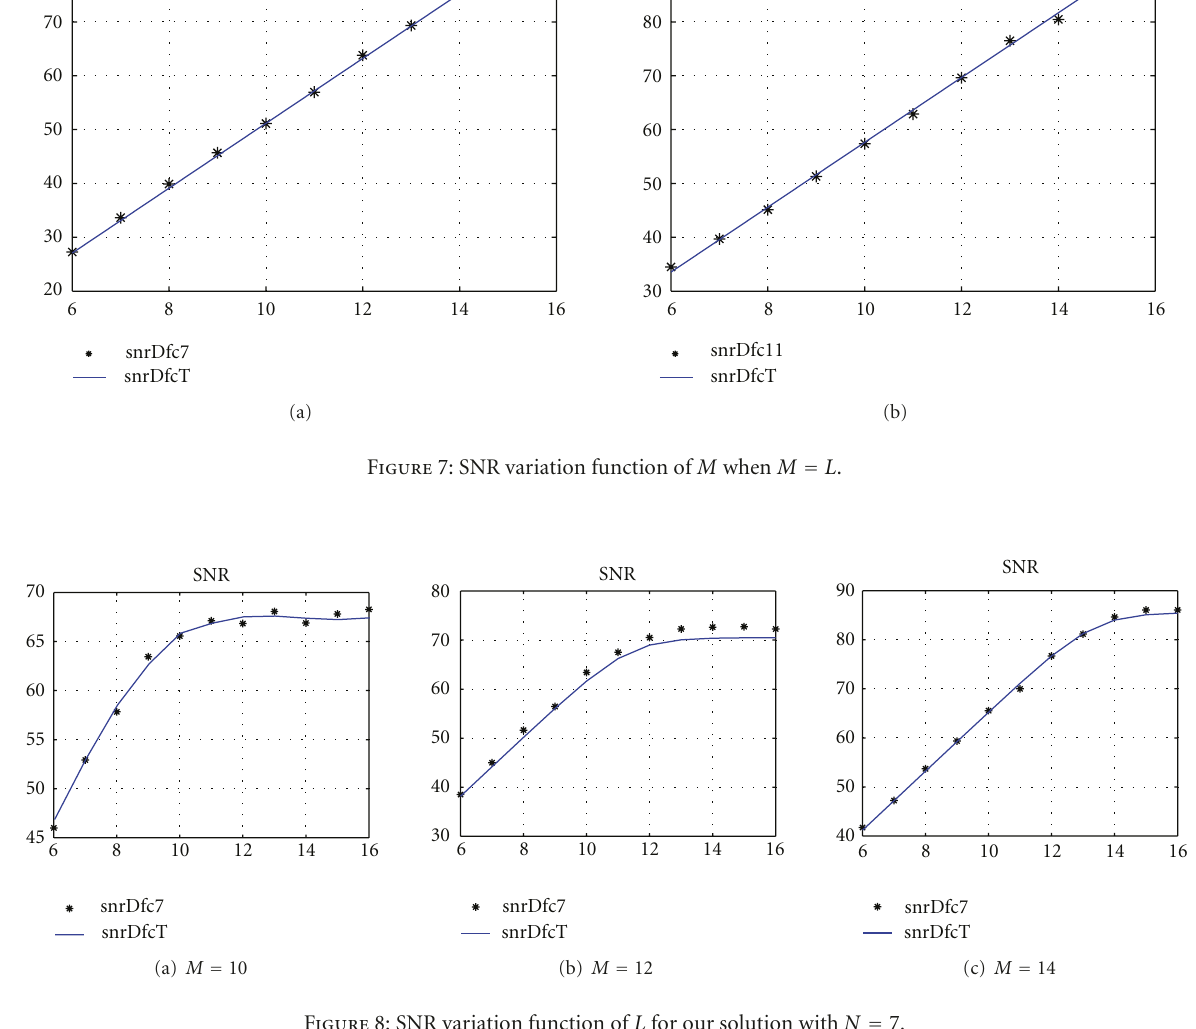
Figure 8: SNR variation function of L for our solution with N = 7.